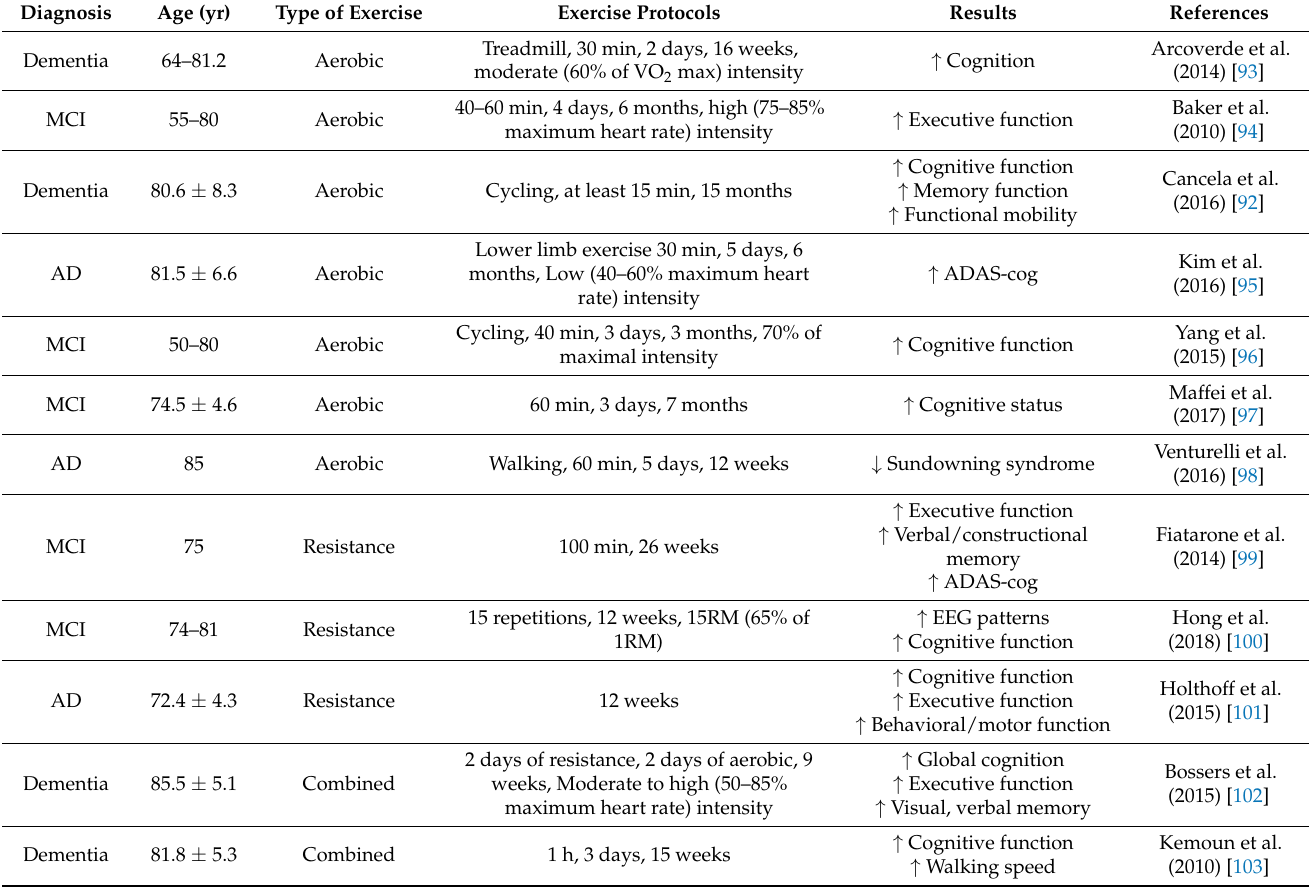
Table 1. Effects of aerobic, resistance, and combined exercise training on